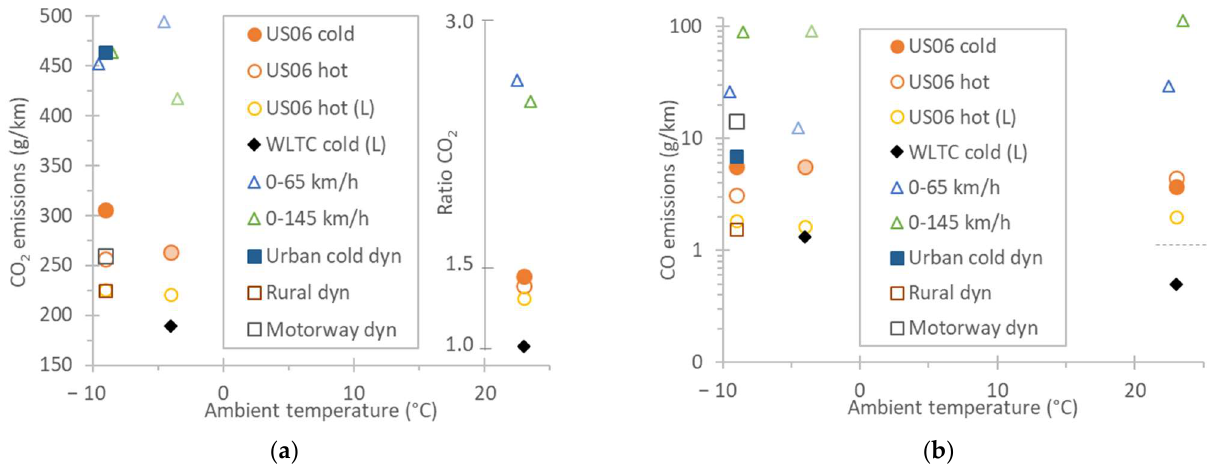
Figure 1. Emissions for various tests at different ambient temperatures. All tests with 84% payload (1850 kg test mass), except those with “L” and the −4 °C tests where the test mass was lower (1550 kg). Auxiliaries were activated only at the −9 °C tests. Solid symbols are cold start tests, while open symbols are hot start tests. Lighter colors indicate tests with lower payload (mass). ( a ) CO 2 . The ratio gives the CO 2 emissions divided to the type approval WLTC value. ( b ) CO. The dotted line shows the limit for the type approval cycle WLTC.